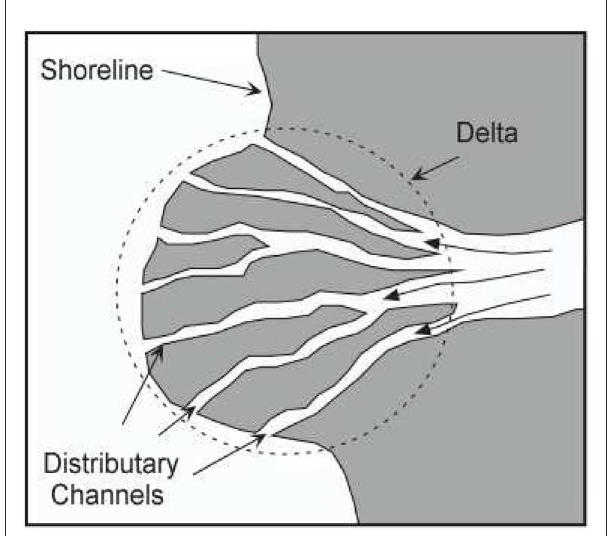
FIGURE7 A typical schematic of a river delta. The primary tributary (right side) branches into several distributaries as it nears the much larger body of water. The Physics Group image of a typical undergraduate’s matriculation through the program loosely follows this image (https://www2.tulane.edu/~sanelson/Natural_Disasters/